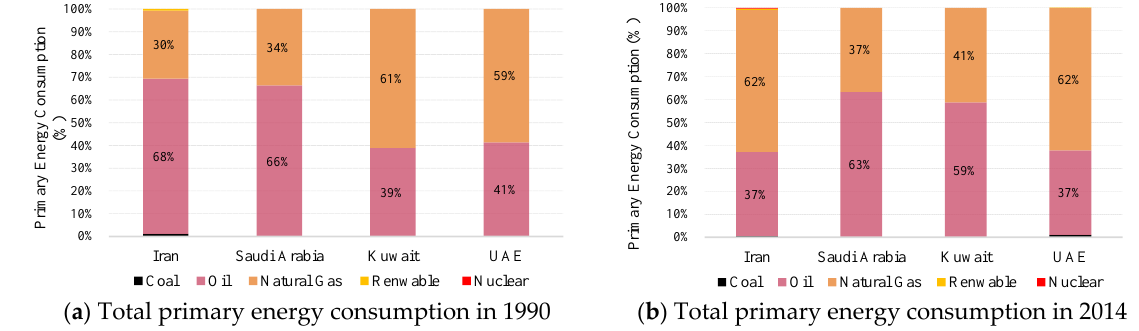
Figure 4. (a ) Primary energy consumption by energy source in 1990; ( b ) primary energy consumption in 2014. Based on data from [21,22,24].